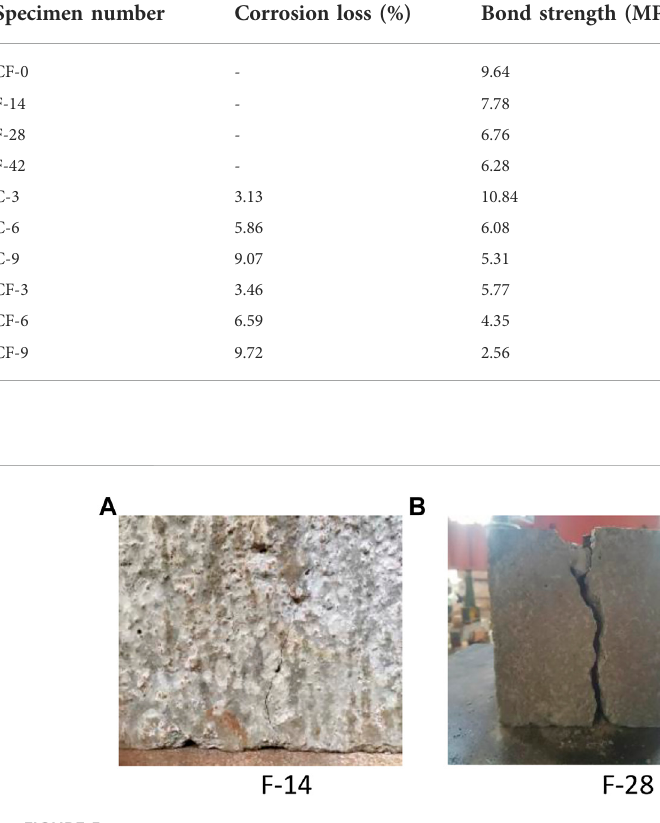
FIGURE 5 Failure mode of fatigue